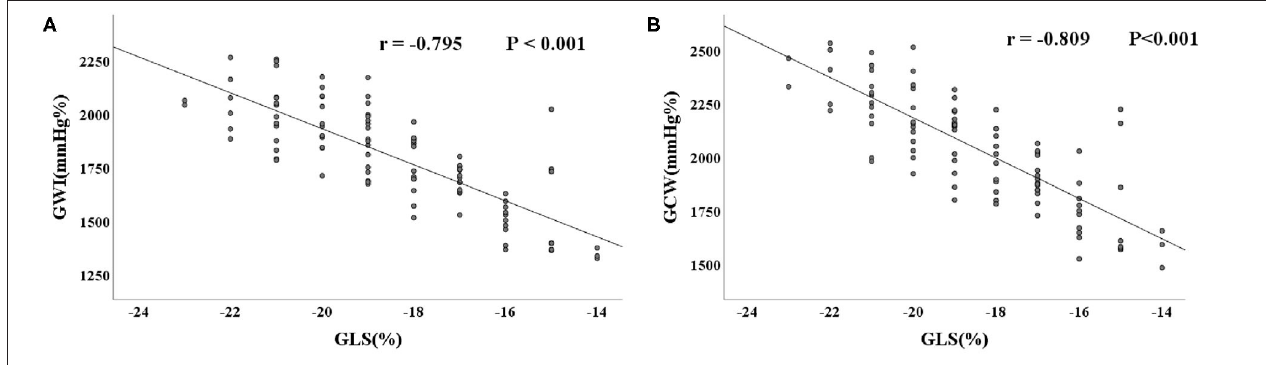
FIGURE 4 | Correlation between myocardial work parameters and GLS. (A) Correlation between GWI and GSL. (B) Correlation between GCW and GSL. PSL, pressure-strain loop; GLS, global longitudinal strain; GWI, global work index; GCW, global constructive work.